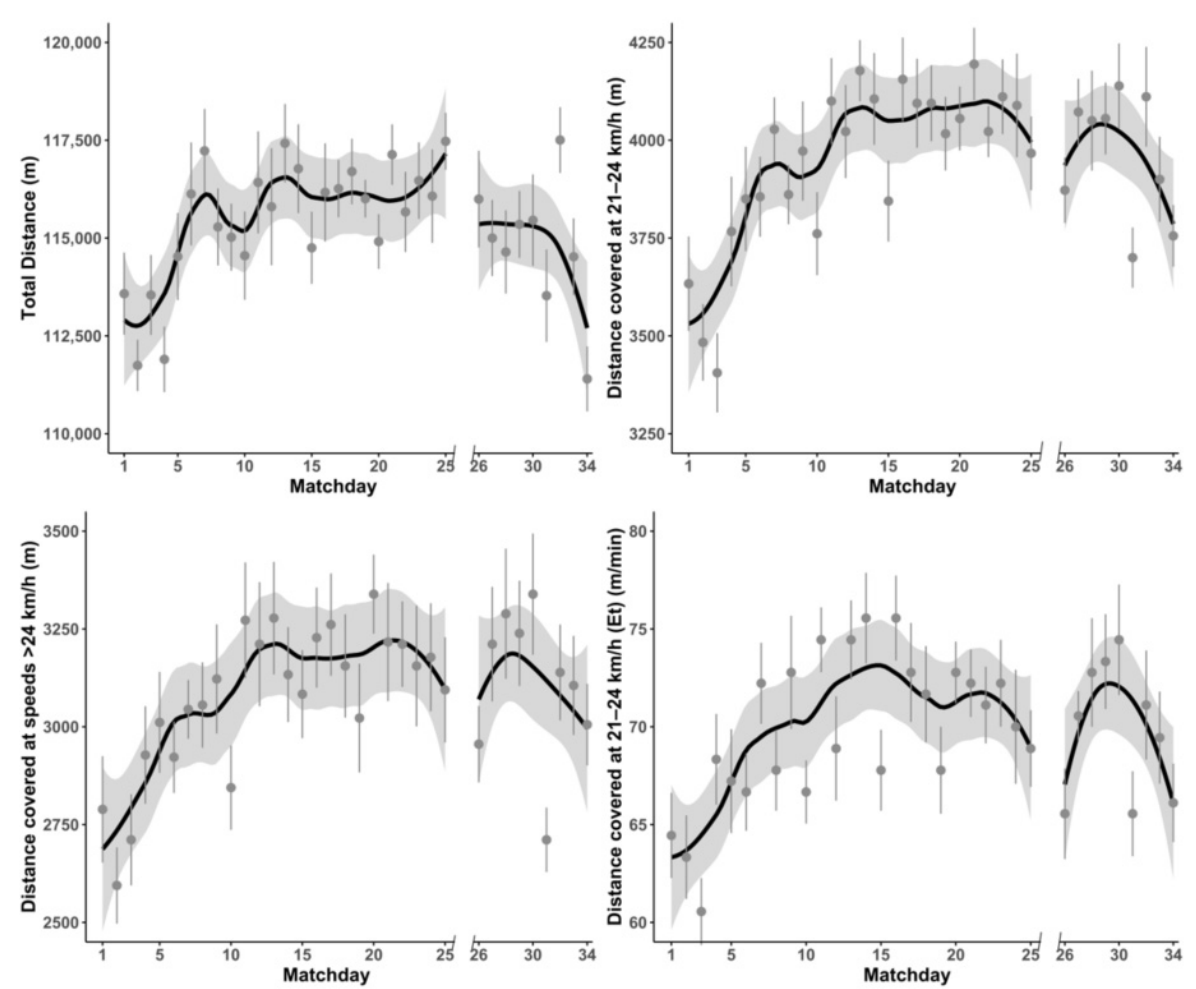
Figure 2. Changes in selected physical performance variables before and after the pandemic lockdown in German Bundesliga teams during official matches. Table 1. Changes of physical and technical match performance in German League before and after the COVID-19 break- Table 2. Changes of physical match performance before and after the COVID-19 lockdown in Polish Ekstraklasa. down (mean and SD).